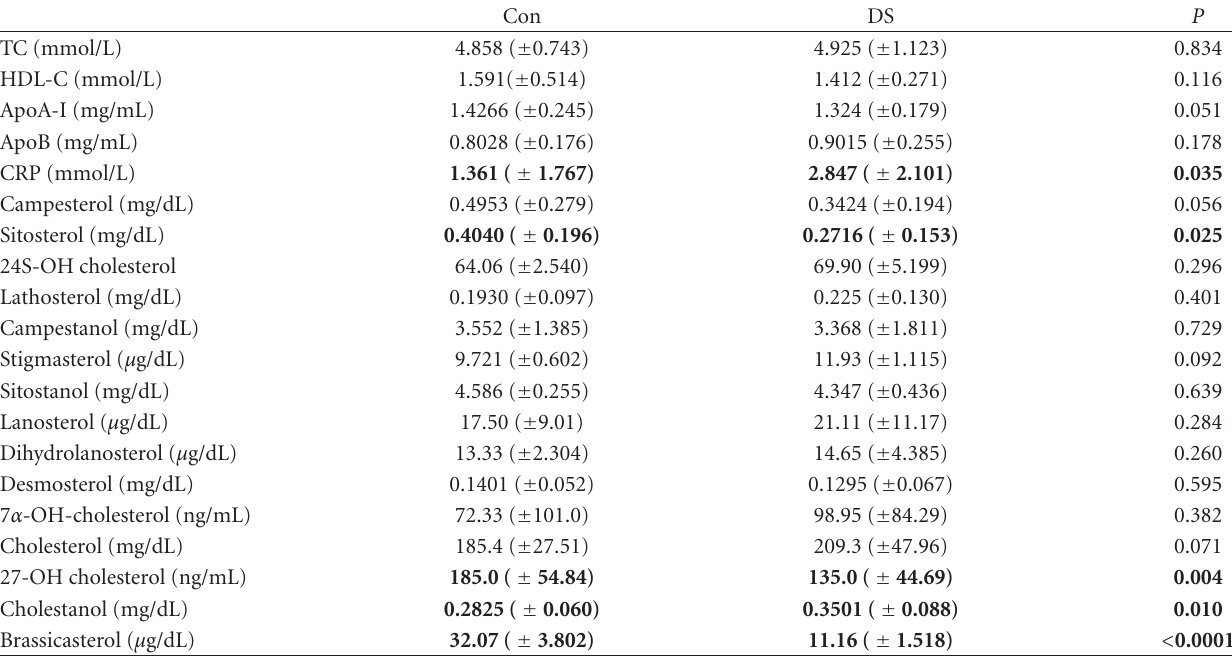
Table 2: Serum analytes in the total control and total DS cohorts. Analytes shown in bold are significantly di ff erent between control and DS groups by unpaired Student’s t -test. Welch’s correction was applied when variances were significantly di ff erent between